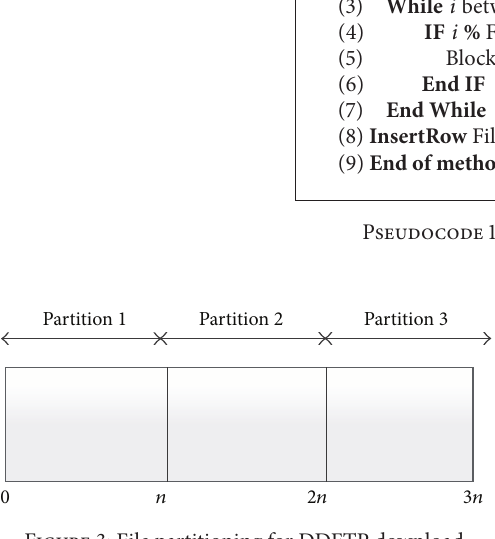
Figure 3: File partitioning for DDFTP download.